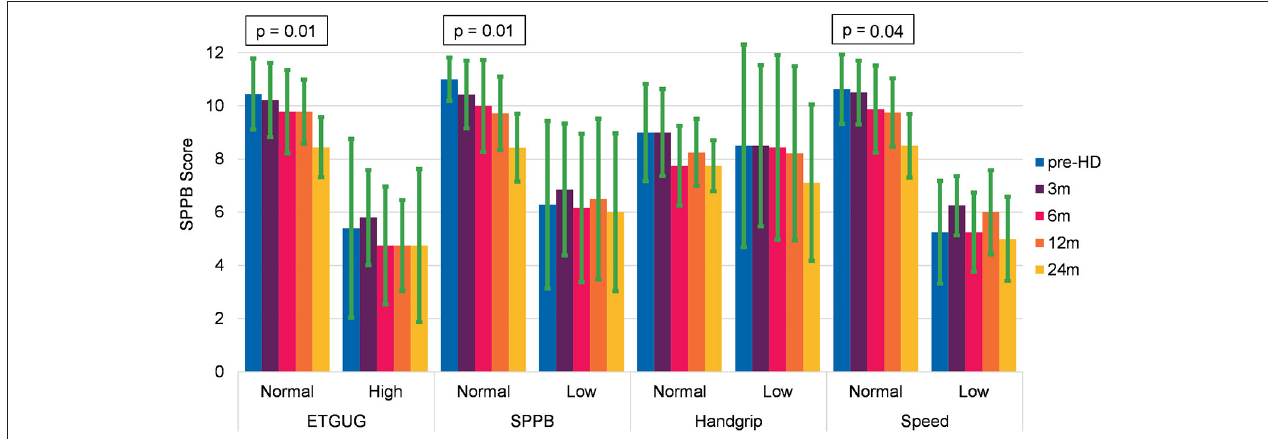
FIGURE 2 | Evolution of the Short Physical Performance Battery (SPPB) in relation to baseline characteristics of physical performance tests (mean and